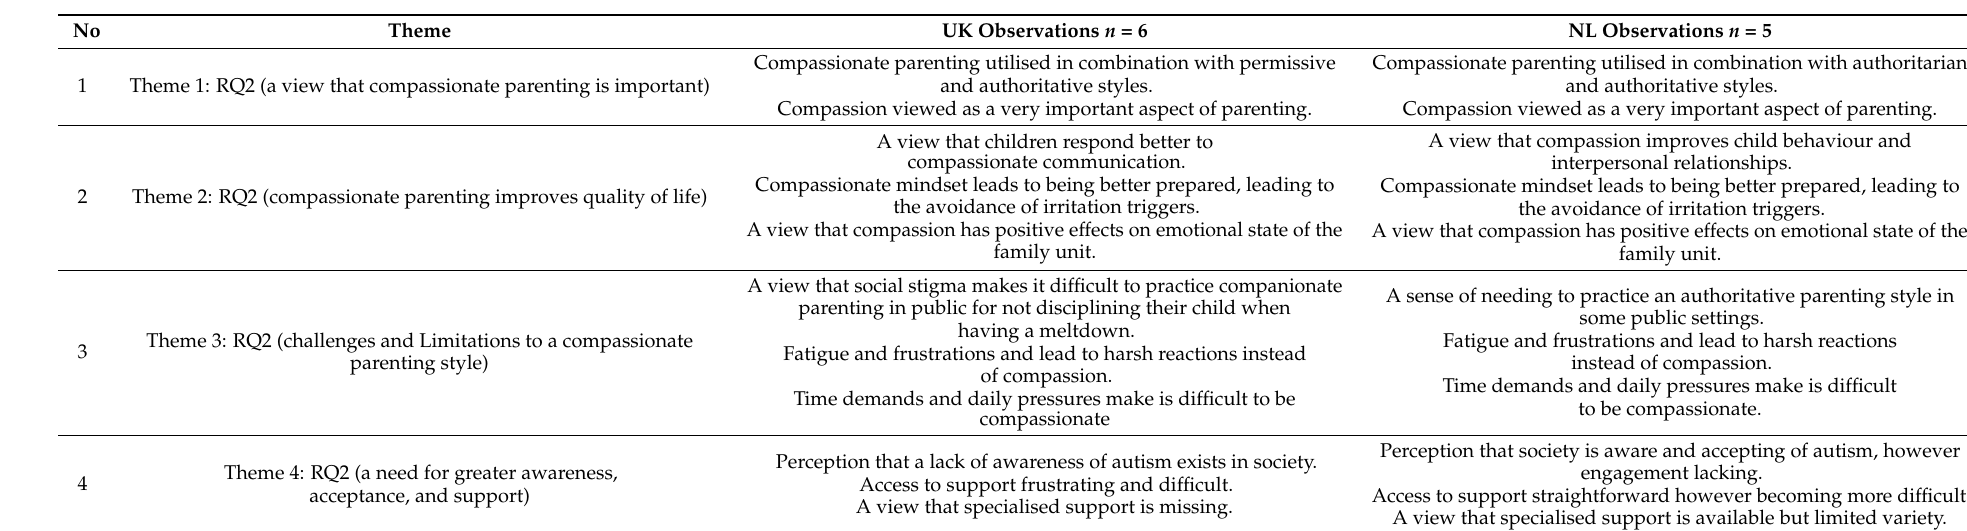
Table 3. Comparison between the UK and the